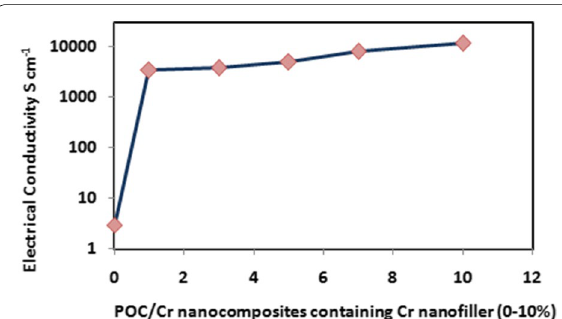
Fig. 6 Plot of electrical conductivity versus load percentage of Cr NPs in